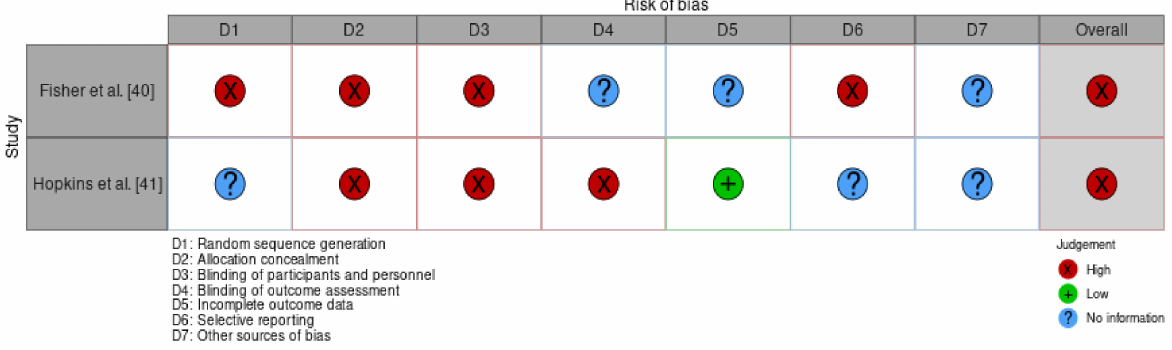
Figure 4. Risk of bias assessment—traffic light system.